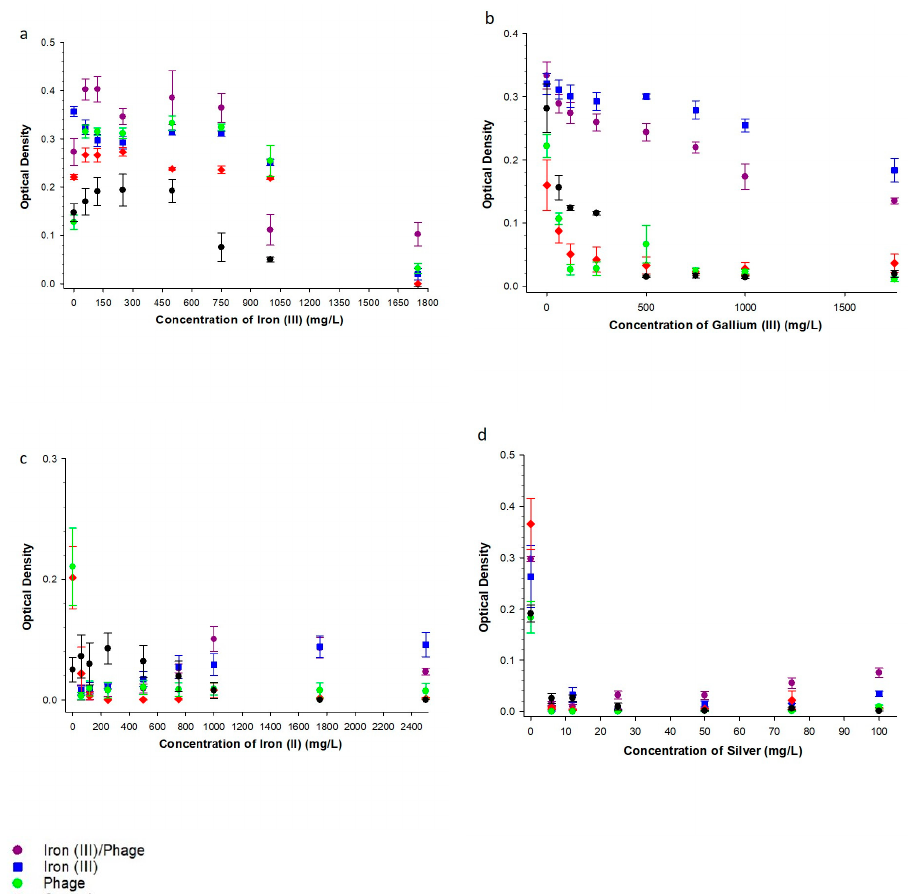
Figure 1. 24 h growth fi tness in iron, gallium (III), and silver (I). ( a ) The mean and SE of 24 h growth Figure 1. 24 h growth fitness in iron, gallium (III), and silver (I). ( a ) The mean and SE of 24 h growth for populations in increasing concentrations of iron (III) to 1750 mg/L. ( b ) The mean and SE of 24 h for populations in increasing concentrations of iron (III) to 1750 mg/L. ( b ) The mean and SE of 24 h growth for populations in increasing concentrations of gallium (III) to 1750 mg/L, ( c ) The mean and growth for populations in increasing concentrations of gallium (III) to 1750 mg/L, ( c ) The mean and SE of 24 h growth for populations in increasing concentrations of iron (II) to 2500 mg/L, ( d ) The mean and SE of 24 h growth for populations in increasing concentrations of silver (I) to 100 mg/L. SE of 24 h growth for populations in increasing concentrations of iron (II) to 2500 mg/L, ( d ) The All growths were measured after 35 days of evolution in excess iron (III) and Escherichia phage T7. mean and SE of 24 h growth for populations in increasing concentrations of silver (I) to 100 mg/L. All growths were measured after 35 days of evolution in excess iron (III) and Escherichia phage T7. The iron (III)/phage- and iron (III)-selected populations showed superior growth rel- ative to the phage-selected, control, and ancestral strain across concentrations for silver (I) (Figure 1d). Surprisingly, however, at the highest silver concentration (100 mg/L), there is Table 1. ( a ) Two-way ANOVA computed via the general linear model (GLM) results are shown an increase in the growth of the iron (III) and iron (III)/phage populations. The genomic for phenotypic assays, iron (III)/phage-resistant population compared to all other populations. analysis showed no selection in genes (such as cusS and ompR) associated with silver re- sistance. In our previous studies, the selection of minerals whose primary component is The general linear model is an analysis of variance to determine the effect of the population (iron iron or share common chemical properties with iron (e.g., gallium and magnetite) confer (III)/phage), the concentration (range tested for each substance), and their interaction. In addition, minor increases in silver resistance [16,18]. Thus, it is possible that other mechanisms as- the GLM computes an F-statistic and the probability of achieving that F-statistic by chance ( p -value). sociated with iron (III) resistance, yet to be determined, could account for an increase in ( b ) Two-Way ANOVA computed via general linear model results are shown for phenotypic assays, silver resistance at the highest concentrations measured. iron (III) vs. phage vs. control vs. ancestor. ( c ) Two-Way ANOVA computed via general linear model results are shown for phenotypic assays, phage vs. control vs. ancestor. ( d ) Two-Way ANOVA computed via general linear model results are shown for phenotypic assays, control versus ancestor. (a) Substance Range Tested Population Concentration